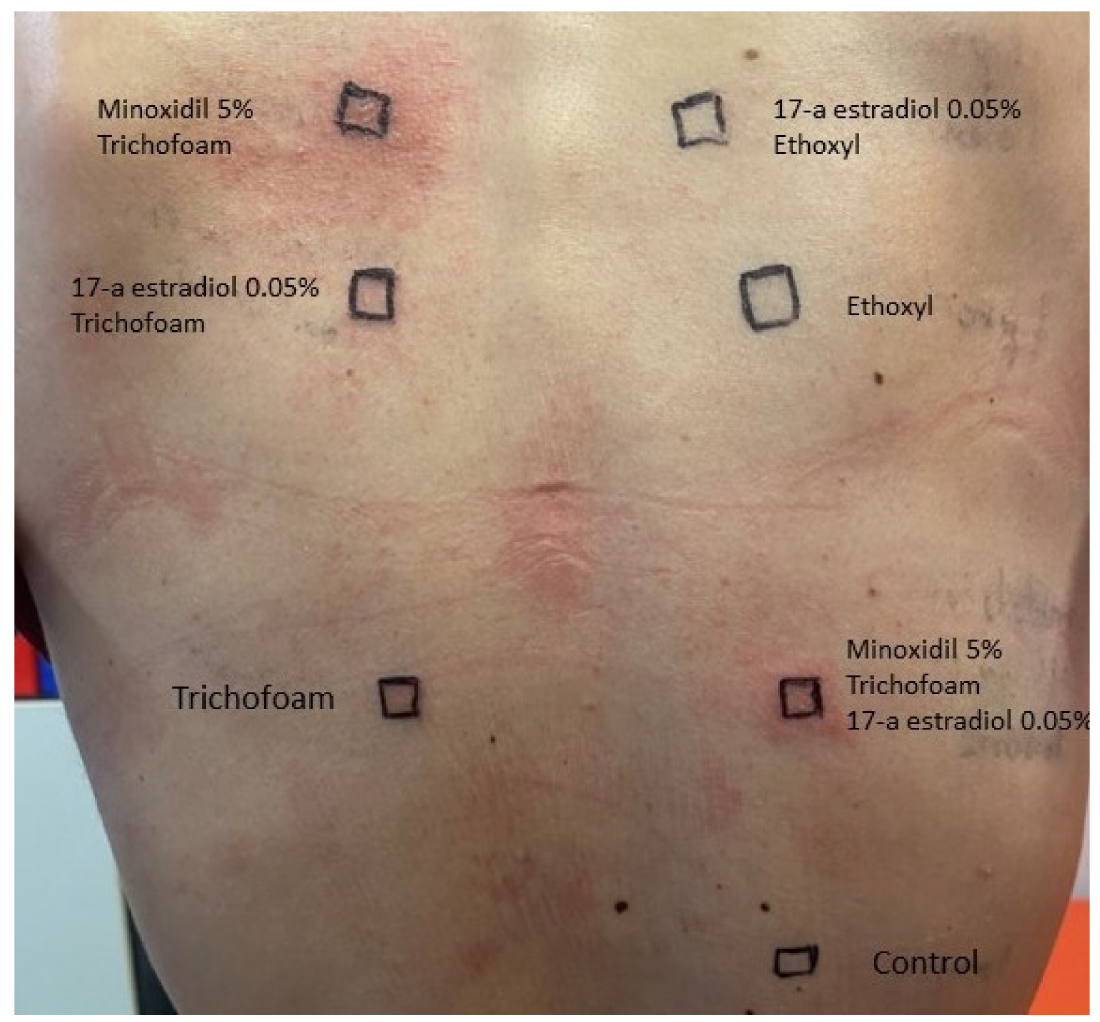
Figure 3. Positive patch tests to a. minoxidil 5% diluted in Trichofoam TM and b. minoxidil 5% and 17-a estradiol 0.05% diluted in Trichofoam TM and negative results to a. Trichofoam TM , b. 17-a estradiol diluted in Trichofoam TM , c. 17-a estradiol diluted in ethoxyl, and d. ethoxyl per se (vehicle